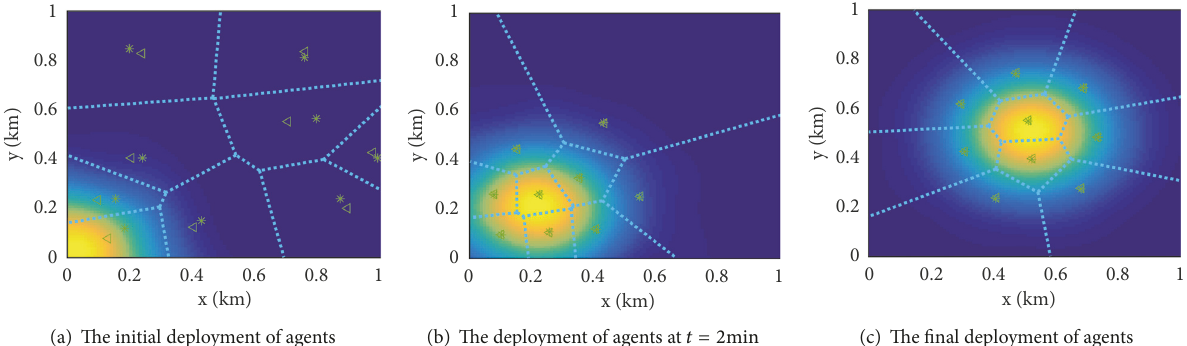
Figure 1: The deployment with time-varying density